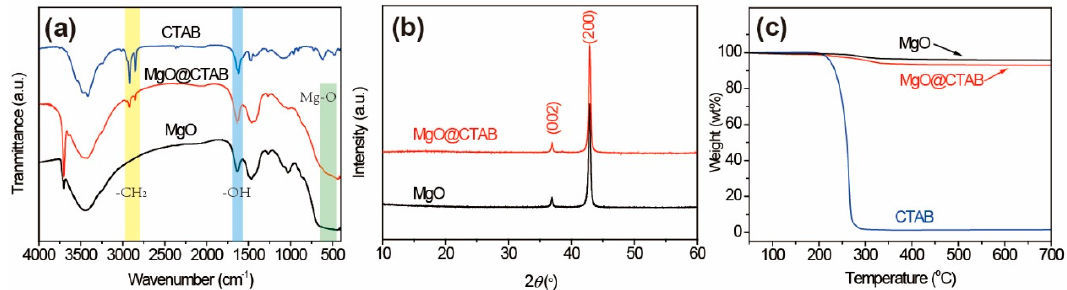
Figure 2. ( a ) Fourier-transform infrared (FT-IR) spectra, ( b ) XRD patterns, and ( c ) thermogravimetric analysis (TGA) curves of MgO and MgO@CTAB. of MgO and